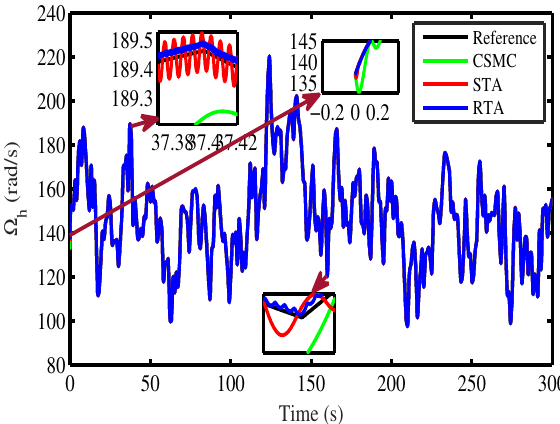
Figure 7. The reference and actual PMSG side-shaft